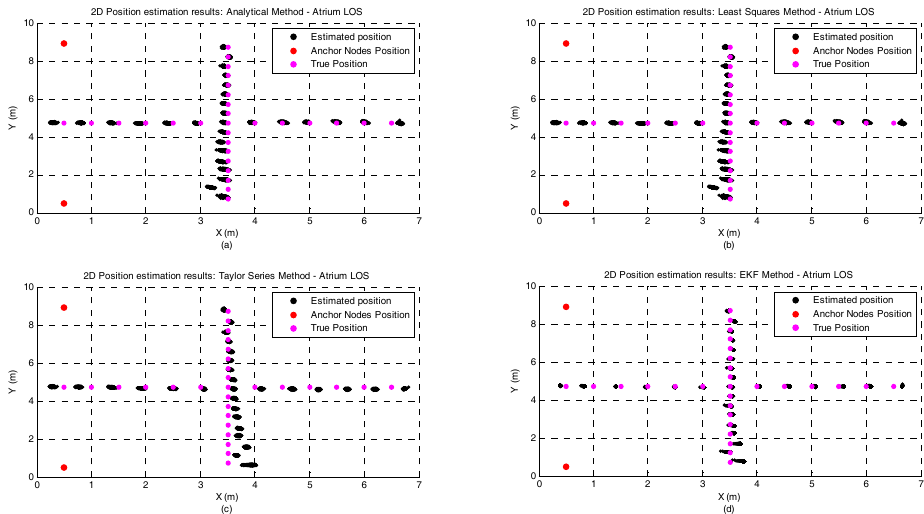
Figure 4. Graphical illustration of the 200 position estimates per test point in the atrium scenario and without human body interference. ( a ) Analytical method; ( b ) Least Squares method; ( c ) Taylor Series Method; and ( d ) EKF Method.